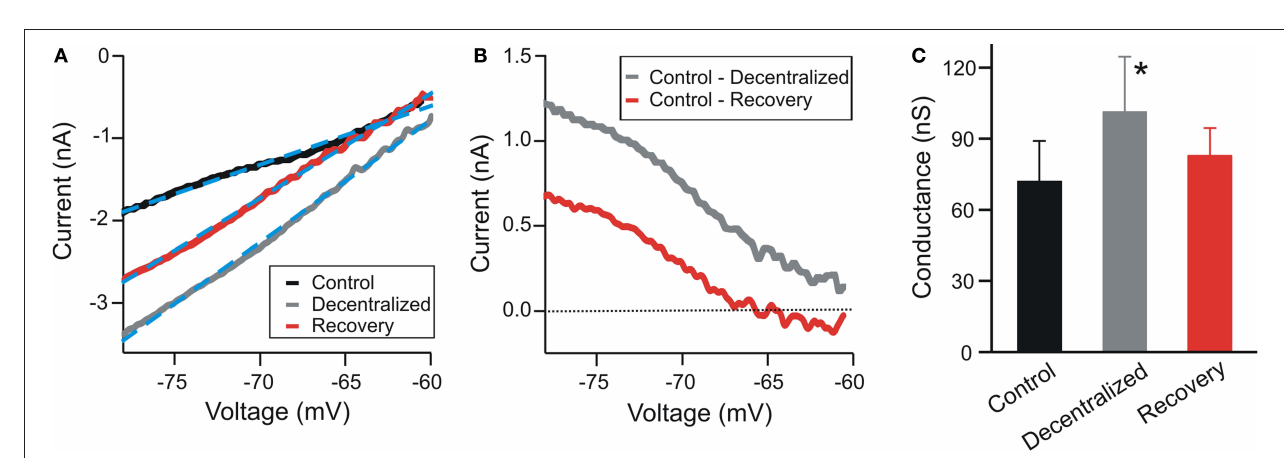
Figure  | effect of decentralization on input conductance. (A) Current vs. voltage relationship (I–V) of a PD neuron obtained by ramping the voltage in two- electrode voltage clamp between − 60 and − 80 mV in 500 ms. The STG was decentralized reversibly with a solution of 0.75-M sucrose. Recovery indicates reversal of decentralization after several washes with normal saline of the sucrose well around the stn. Dashed blue lines indicate linear fits ( I = aV + b;